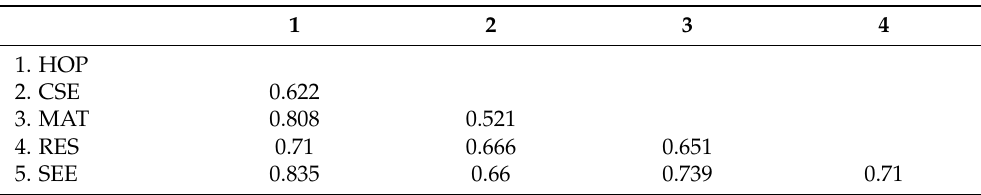
Table 4. HTMT criterion.